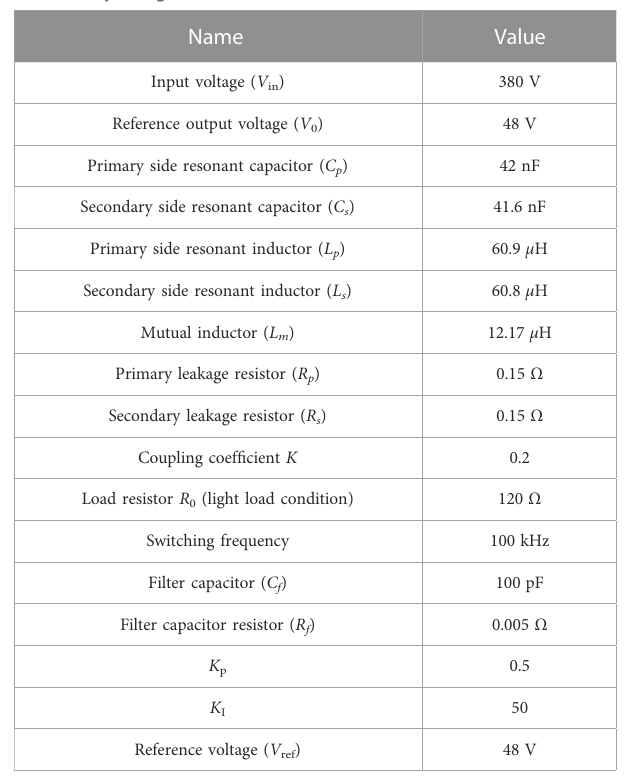
TABLE 3 Key ratings in main circuit.